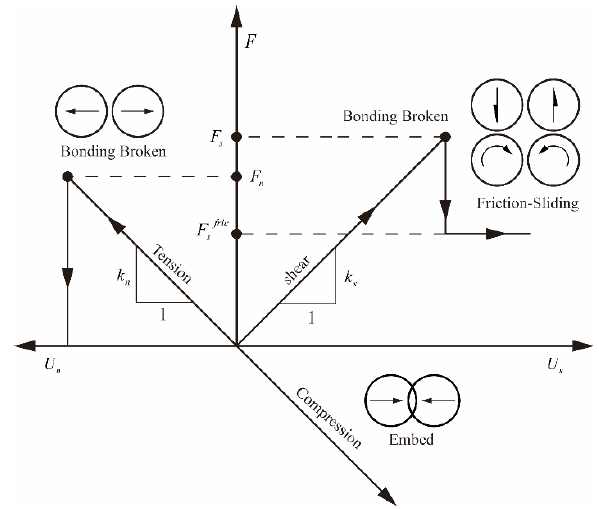
Figure 2. Force on particle and failure process.